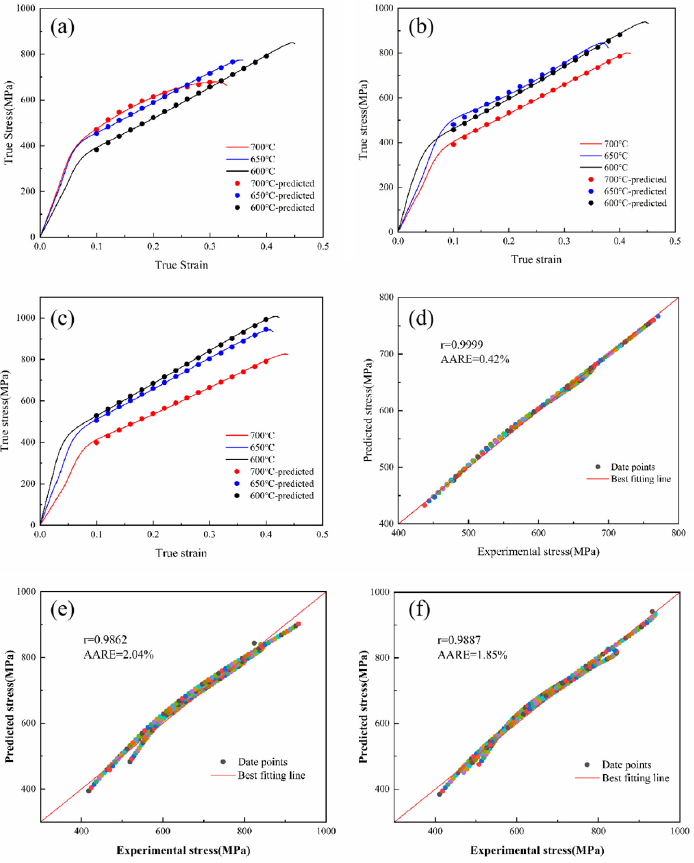
Figure 5. Comparison between predicted and experimental flow stress of CHN327 alloy at different temperatures and strain rates by the modified Voce equation: ( a ) 0.001 s − 1 ; ( b ) 0.01 s − 1 ; ( c ) 0.1 s − 1 ; correlation between experimental and fitted flow stress values: ( d ) the modified Voce; ( e ) Hollomon; ( f ) Swift.